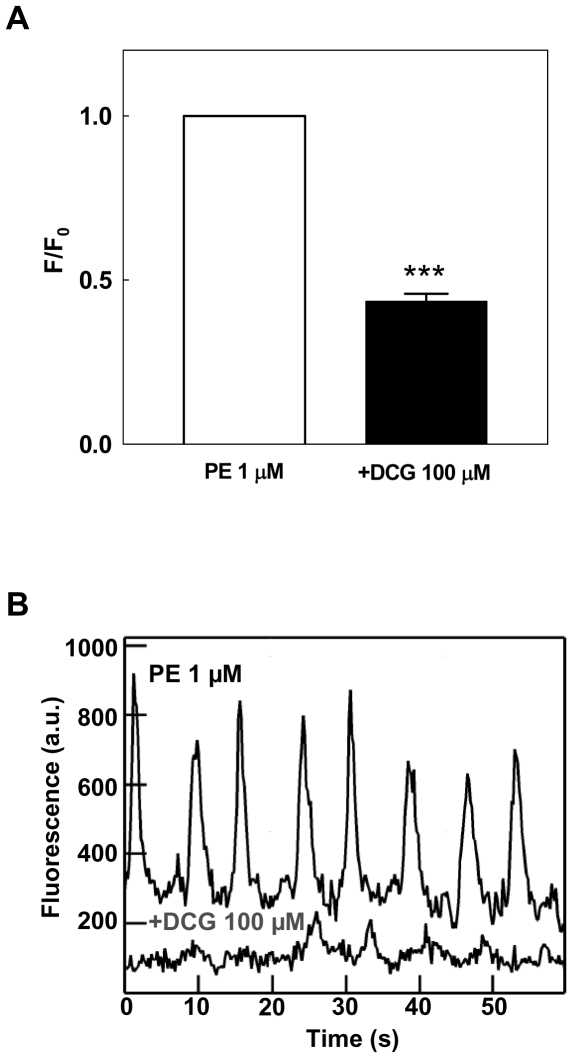
Effect of DCG on agonist-mediated changes in VSM Ca2+.(A) Fluo-2-loaded arteries were treated with PE 1 µM. Ca2+ fluorescence was measured before and after incubating with DCG 100 µM for 5 minutes. DCG reduced the arterial VSM Ca2+ fluorescence by ∼50%. (B) An example of fluorescence tracings from the same artery before and after addition of DCG is shown (a.u., arbitrary units). (n = 5 arteries in each group).